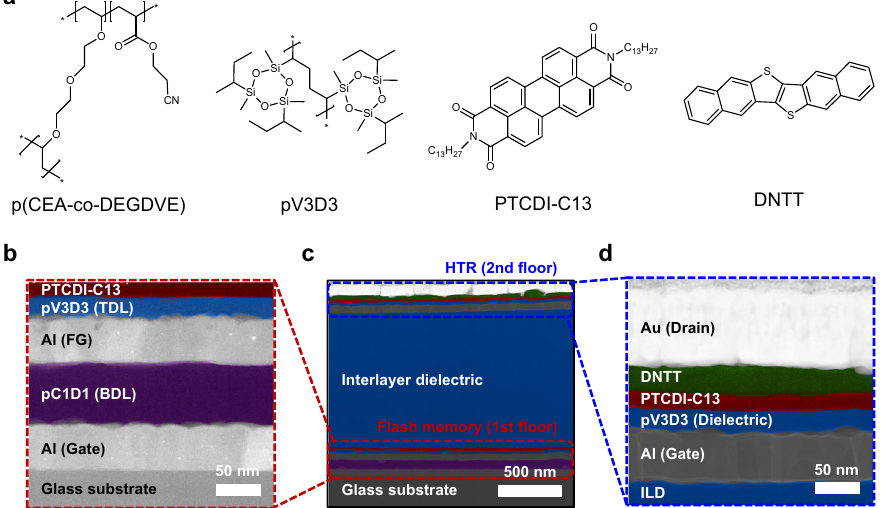
Fig. 2 Materials and device structures of the 3D T-inverter. a The chemical structures of the polymer dielectrics and organic semiconductors used in this study. The high-resolution transmission electron microscope (HRTEM) images of the b fl ash memory, c 3-dimensional (3D) ternary logic inverter (T- inverter), and d heterojunction transistor (HTR). The false-color modi fi cation was attempted to organic layers to distinguish each layer in HRTEM fl ash memory and HTR were utilized as a pull-down and pull-up dielectric constant (the dielectric constant, k > 6) while retaining transistor and those devices were fabricated on the fi rst and the insulating performance (breakdown fi eld, E break > 3 MV/ cm) 42 , was used as blocking dielectric layer (BDL) in this study. second fl oor, respectively. It should be noted that the drain electrode on top of the heterojunction in HTR was interconnected a low dielectric constant ( k < 2.3) 40 was also employed as a tun- to the drain electrode in the fl ash memory and used as an output neling dielectric layer (TDL) in the fl ash memory, and gate electrode in the inverter operation to induce an intermediate logic dielectric layer (GDL) in the HTR to provide a non-polar inter- state 29 . The chemical structures of the polymer dielectrics and face for the facilitated charge transport in the organic organic semiconductors used in this study are shown in Fig. 2a. semiconductors 44 . The dielectric layers were deposited using the For the polymer dielectric layers, poly(2-cyanoethyl acrylate- co - diethylene glycol divinyl ether) [p(CEA- co -DEGDVE)] (named iCVD process, which commonly exhibited robust insulating pC1D1), whose composition was optimized to maximize the performance even at a thickness of 100 nm for BDL and 24 nm